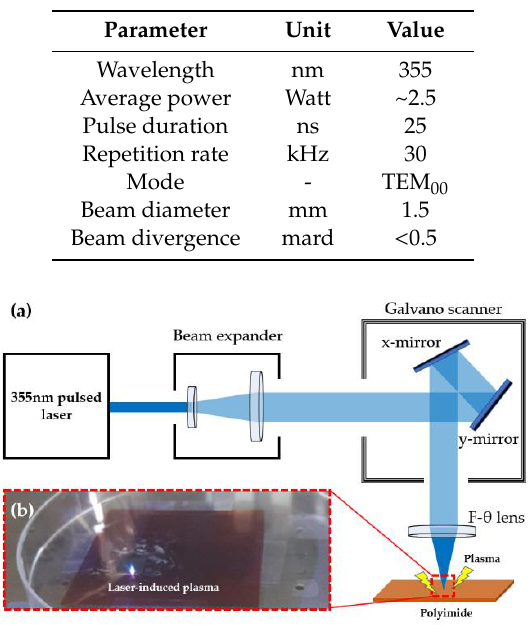
Figure 1. ( a ) Schematic illustration of the laser system. ( b ) Photograph of laser-induced plasma on polyimide (PI). Table 1. Specifications of the 355 nm UV pulsed laser.